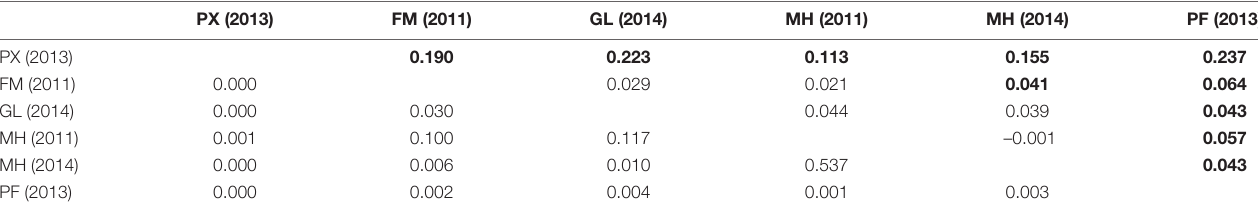
Bold indicates pairwise comparisons are statistically significant (P < 0.007; with Bonferroni).